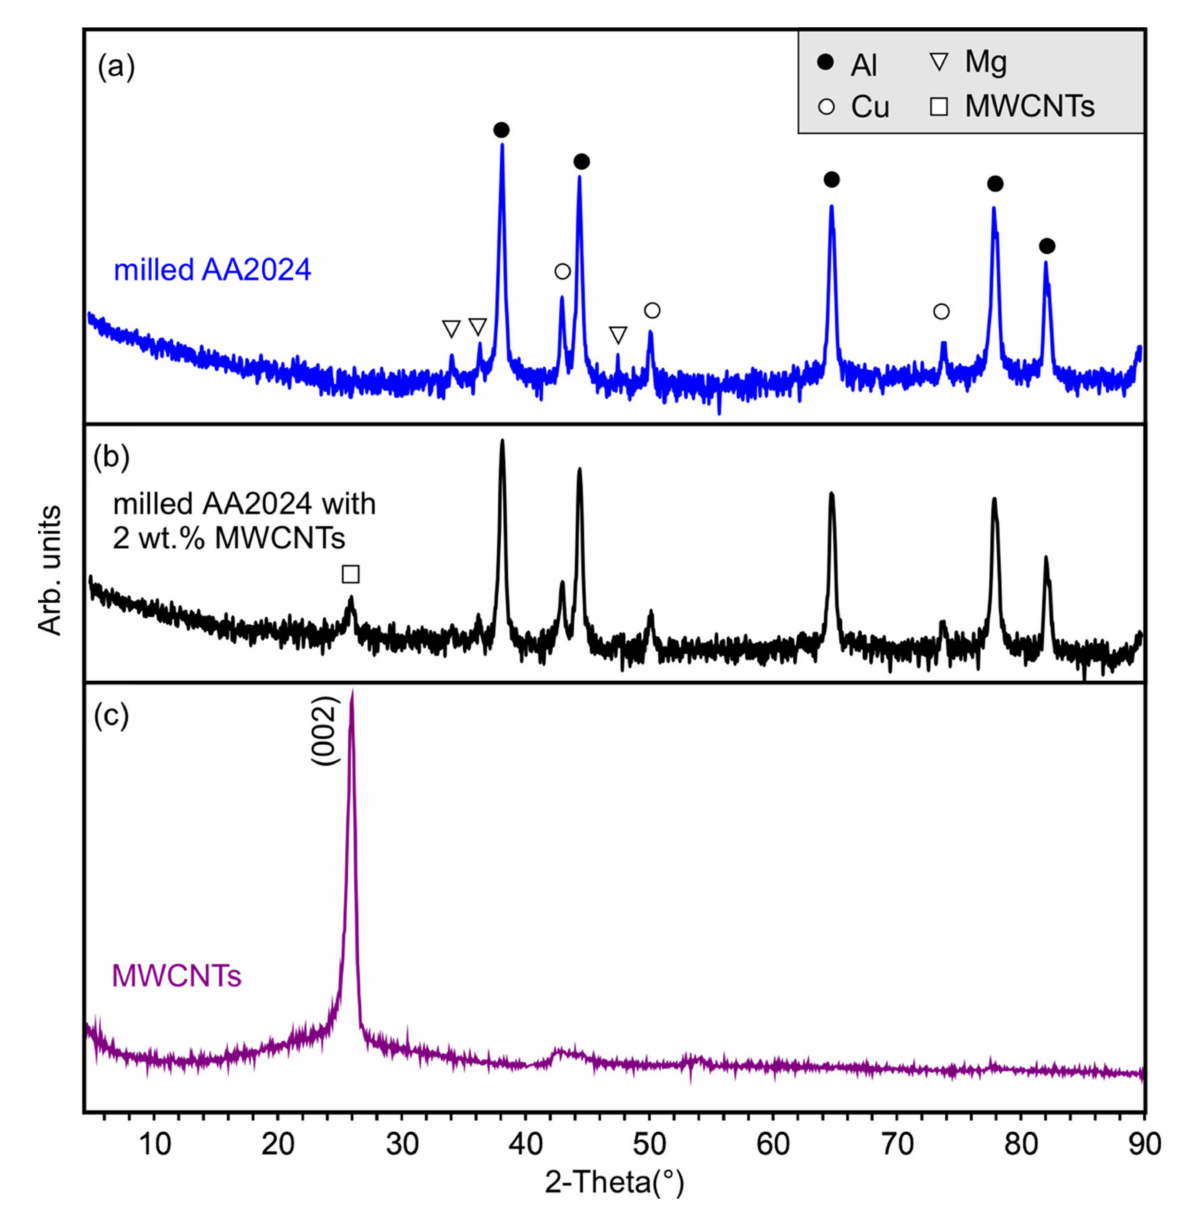
Figure 2. XRD patterns of ( a ) the milled AA2024, ( b ) the milled nanocomposite with 2% MWCNTs powder mixtures, and ( c ) the initial MWCNTs